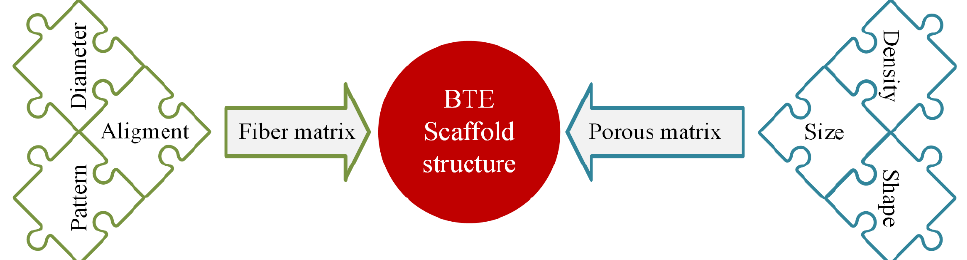
Figure 6. The most important structural and morphological parameters of a scaffold used in BTE.